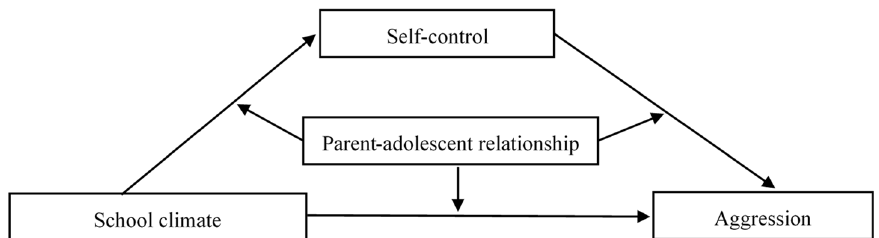
Figure 1. The proposed moderated mediation